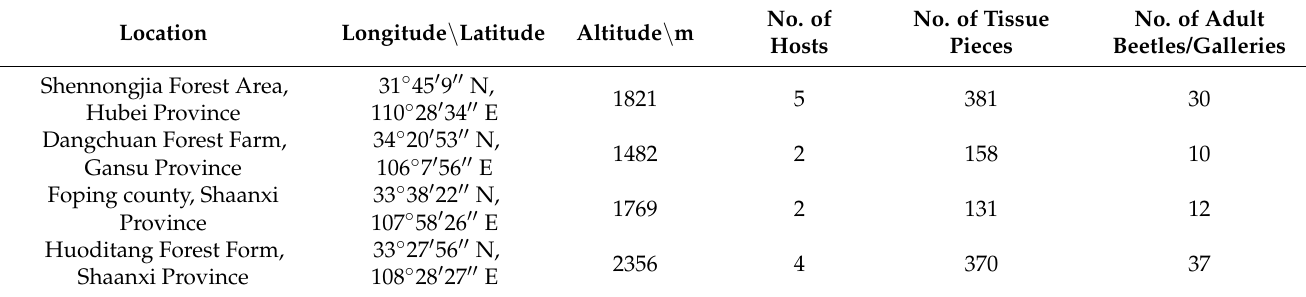
Table 1. Basic information on the sample collection plots and samples obtained from P. armandii infested D. armandi in western